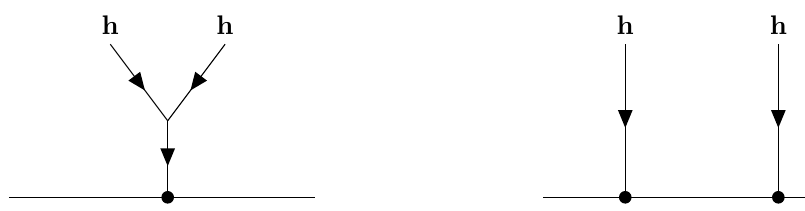
Figure 2 . Feynman diagrams whose BRST variation determines the classical w, w OPEs. The horizontal line represents the defect supported on L 0 , and the solid dots represent couplings to w